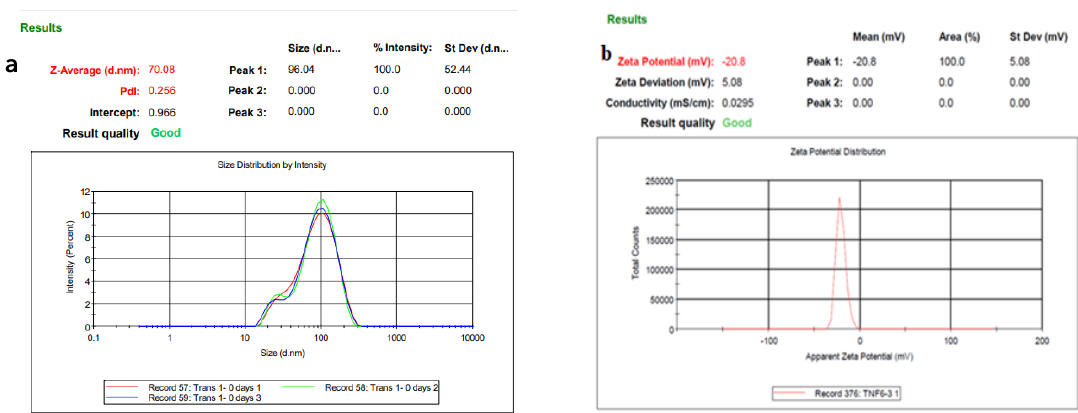
Figure 3. ( a ) DLS illustrating the size distribution of the particles formed; ( b ) Zeta potential of Cisplatin-loaded SLNs.